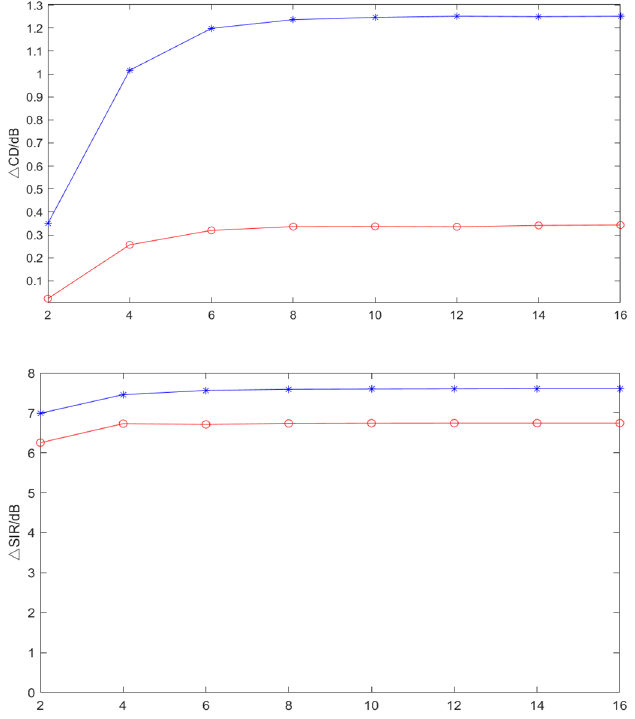
Figure 3. Test results related to the filter order L between the proposed method (red line) and ISCLP (blue line).